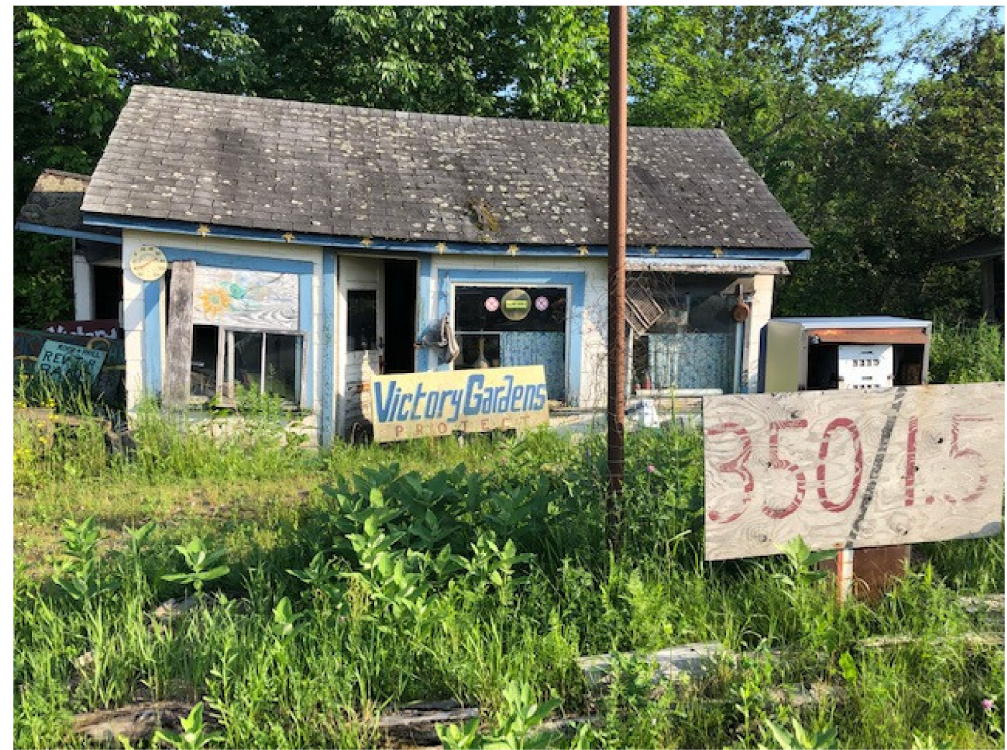
Figure 11. From transect across Central Maine: Stage 2–End of Life. Boston’s filling station, Athens, Maine. (Photo courtesy of Betty Austin).